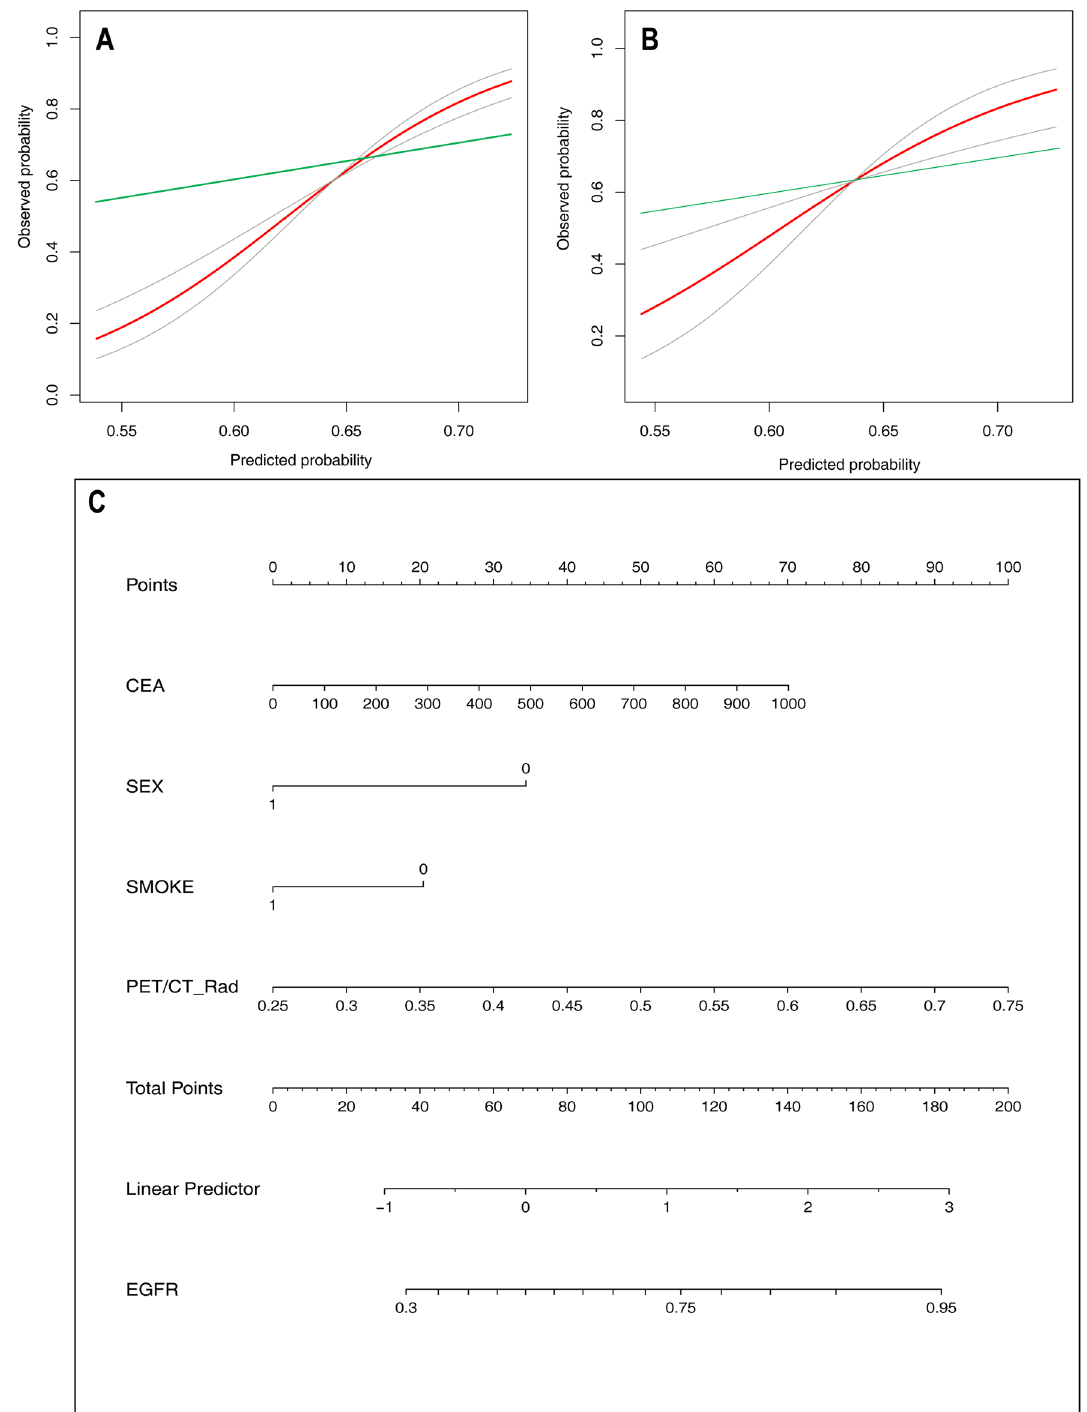
Fig. 5 The nomogram and calibration curves of the PET/CT joint model for predicting EGFR mutation in lung adenocarcinoma. A The calibration curve in the training set. B The calibration curve in the testing set. C The nomogram. The horizontal axis is the predicted incidence of the EGFR mutation, and the vertical axis is the observed incidence of the EGFR mutation. The red line is the reference line, indicating that the predicted value is equal to the actual value. The green line is the calibration curve, and the areas between two gray line represent the 95% CI on both